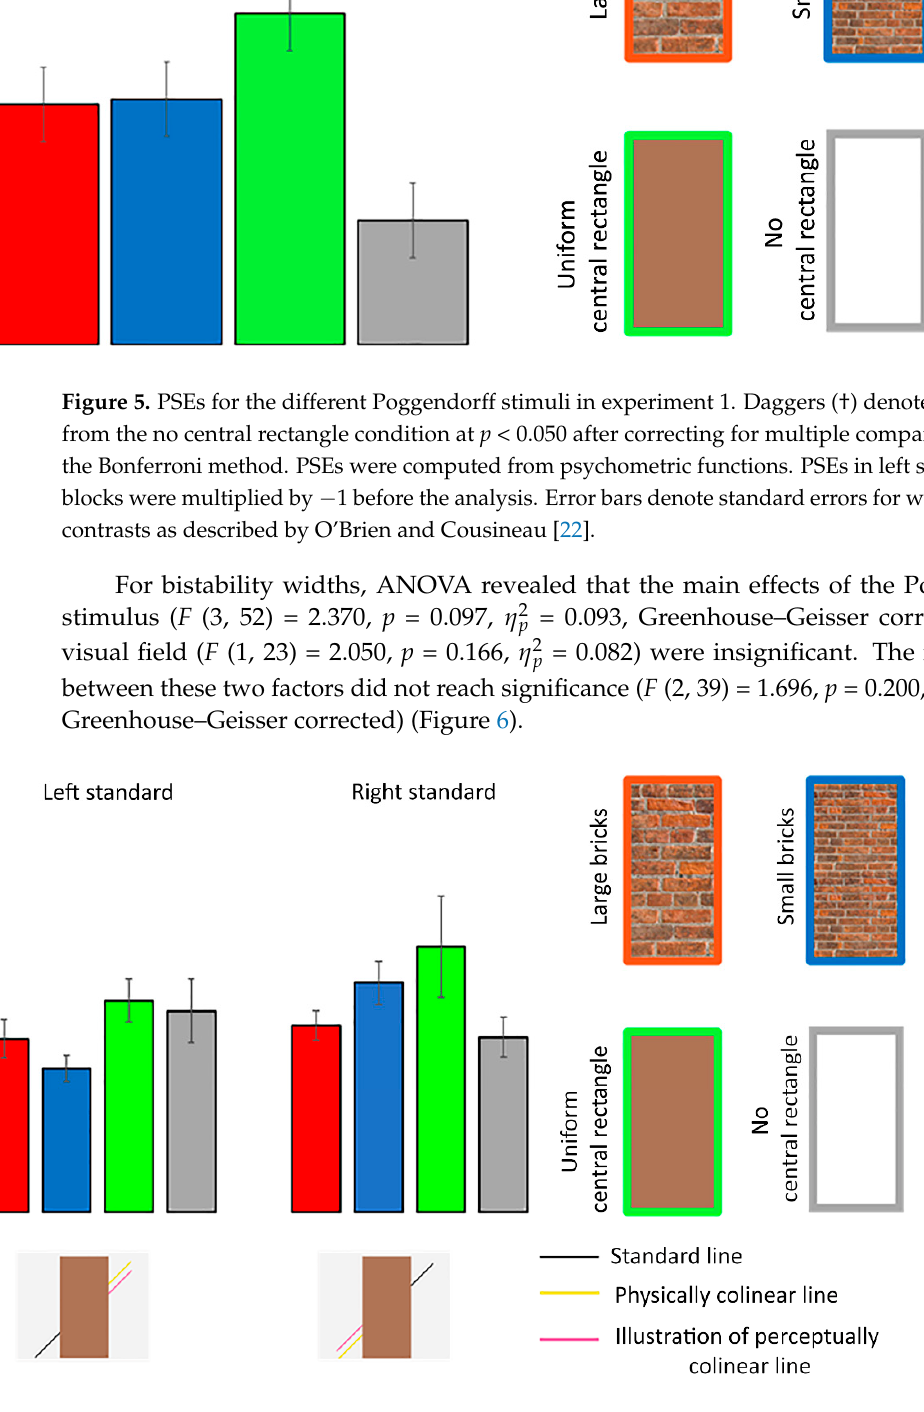
Figure 6. Mean bistability widths for the different Poggendorff stimuli in experiment 1. Mean bistability widths were computed by subtracting P = 0.25 from P = 0.75. Error bars denote standard errors for within-subject contrasts as described by O’Brien and Cousineau [22].